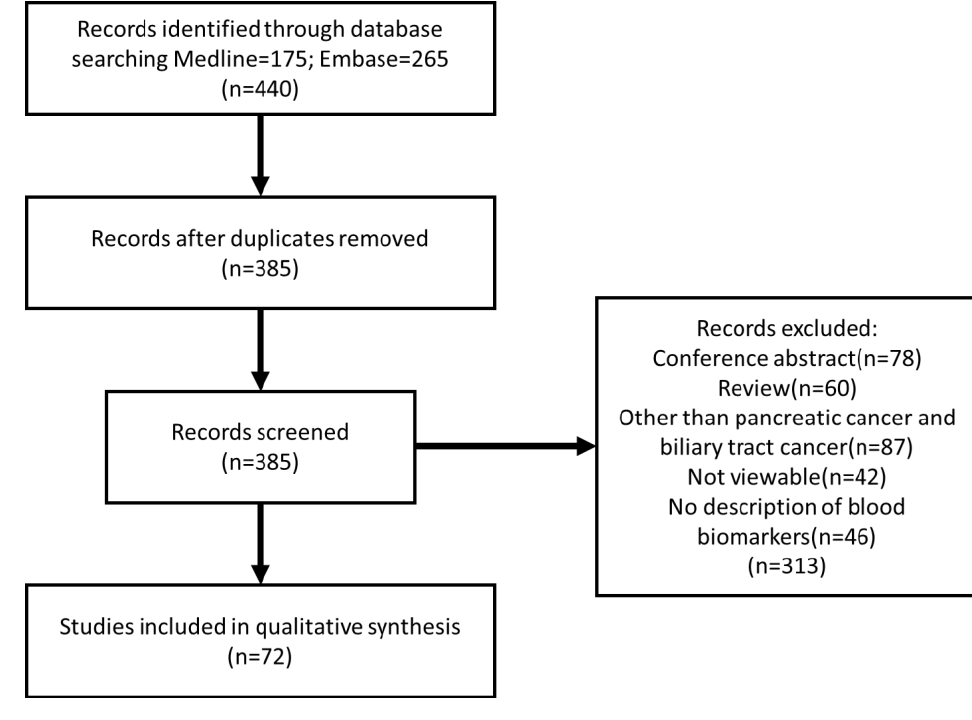
Figure 1. Flow diagram of literature search.